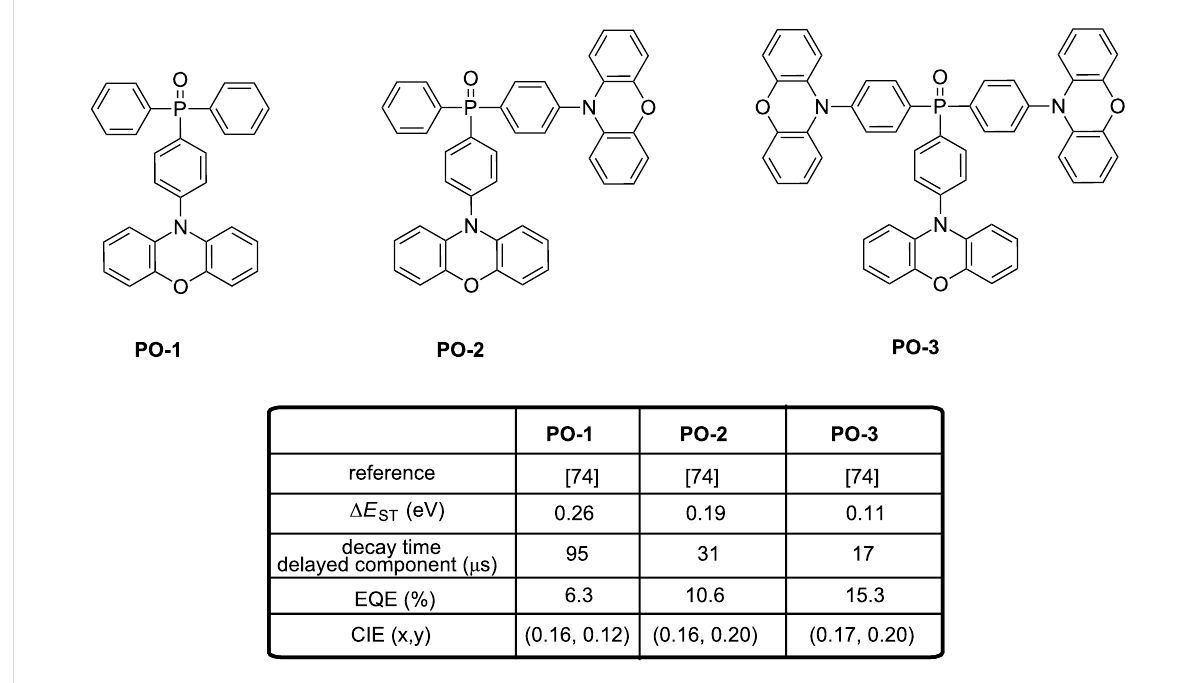
Figure 13: Phosphine oxide-based TADF blue emitters PO-1 – PO-3 .